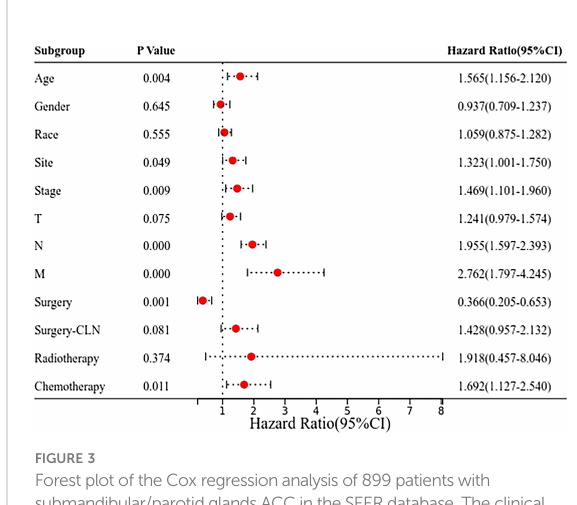
FIGURE 3 Forestplotof theCox regressionanalysisof 899patientswith submandibular/parotidglandsACCintheSEER database.The clinical